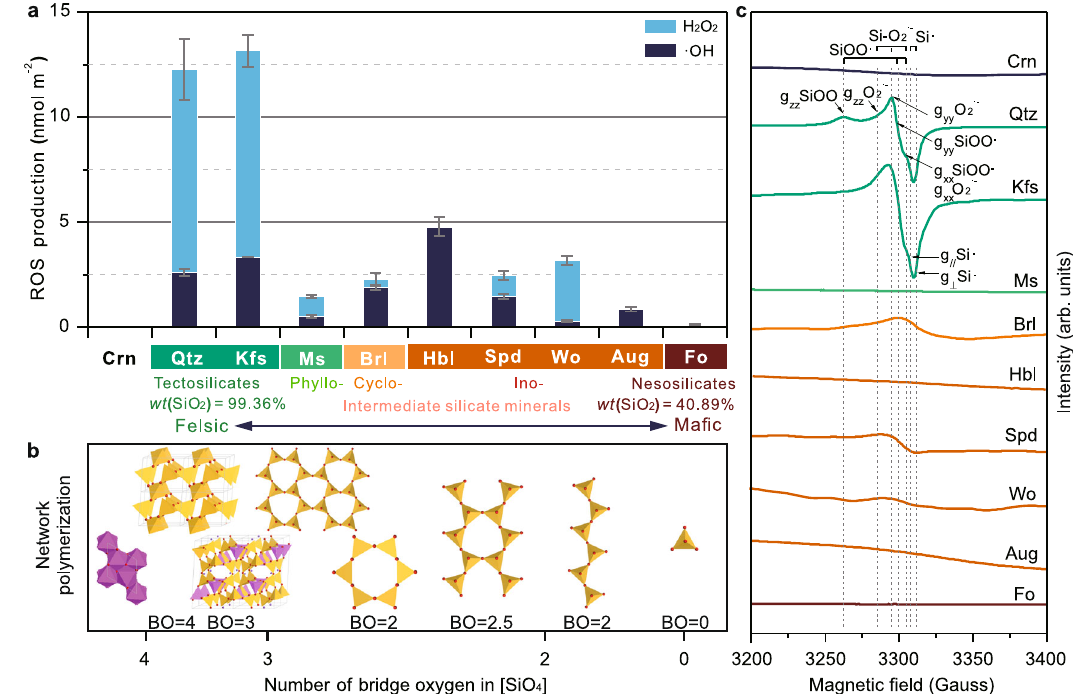
Fig. 1 The ROS production and EPR spectra of the abraded rock-forming silicates with varied polymerization degrees of Si-O tetrahedron. a ROS production of the abraded silicates. The error bars present standard deviations of three independent replicates. b Schematic diagram of [SiO 4 ] polymerization in silicates in the order of the number of bridge oxygens (BO) shared between [SiO 4 ] (the yellow polyhedron) or [AlO 4 ] (the pink polyhedron) in minerals (modi fi ed from Hurowitz et al. 31 ). c EPR spectra of the abraded silicates. Three SBR species were identi fi ed, i.e., peroxy radical ( ≡ SiOO·, g zz = 2.064; g yy = 2.007; g xx = 2.002), surface-bound superoxide ion ( ≡ Si + O 2 · – , g zz = 2.044; g yy = 2.010; g xx = 2.002), and E ’ center (Si·, g // = 2.001; g ┴ =